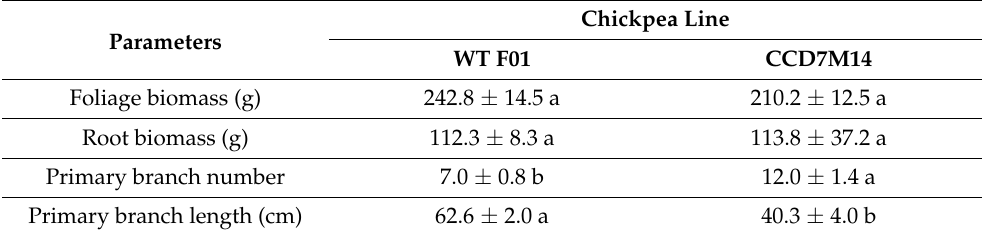
Table 4. Morphological characteristics of CCD7M14 compared to WT F01 chickpea.